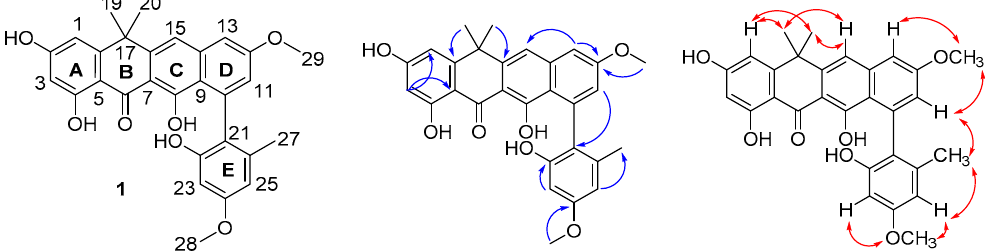
Figure 1. Structure of accramycin A ( 1 ) with key HMBC ( → ) and NOESY ( ↔ ) correlations in DMSO- d 6 .